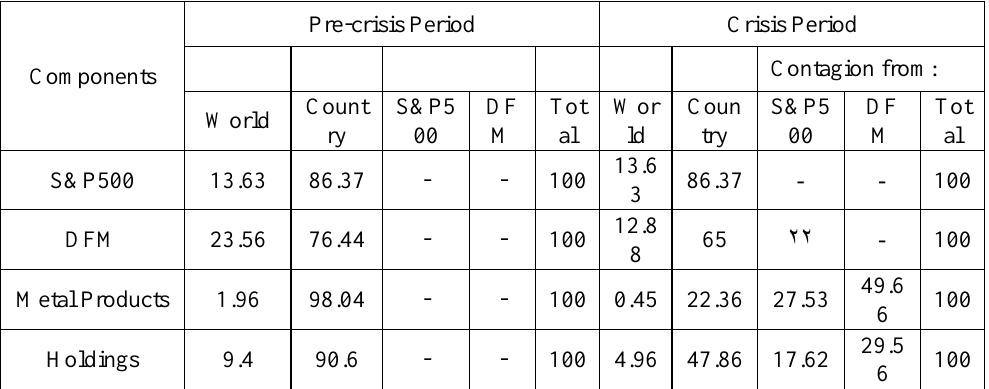
Table 5-2. Pre-Crisis and Crisis Periods Stock Return Variance Analysis Results